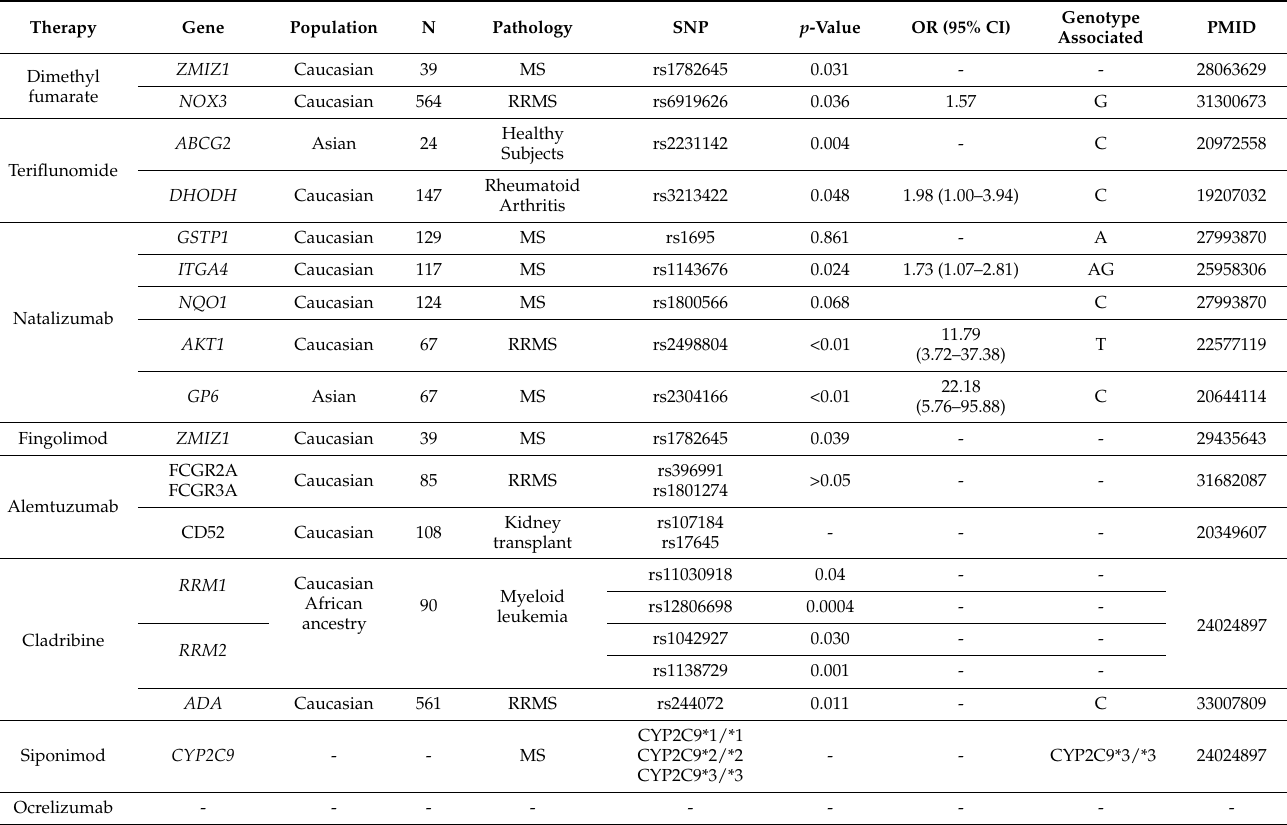
Table 1. Influence of gene polymorphisms on new therapies in multiple